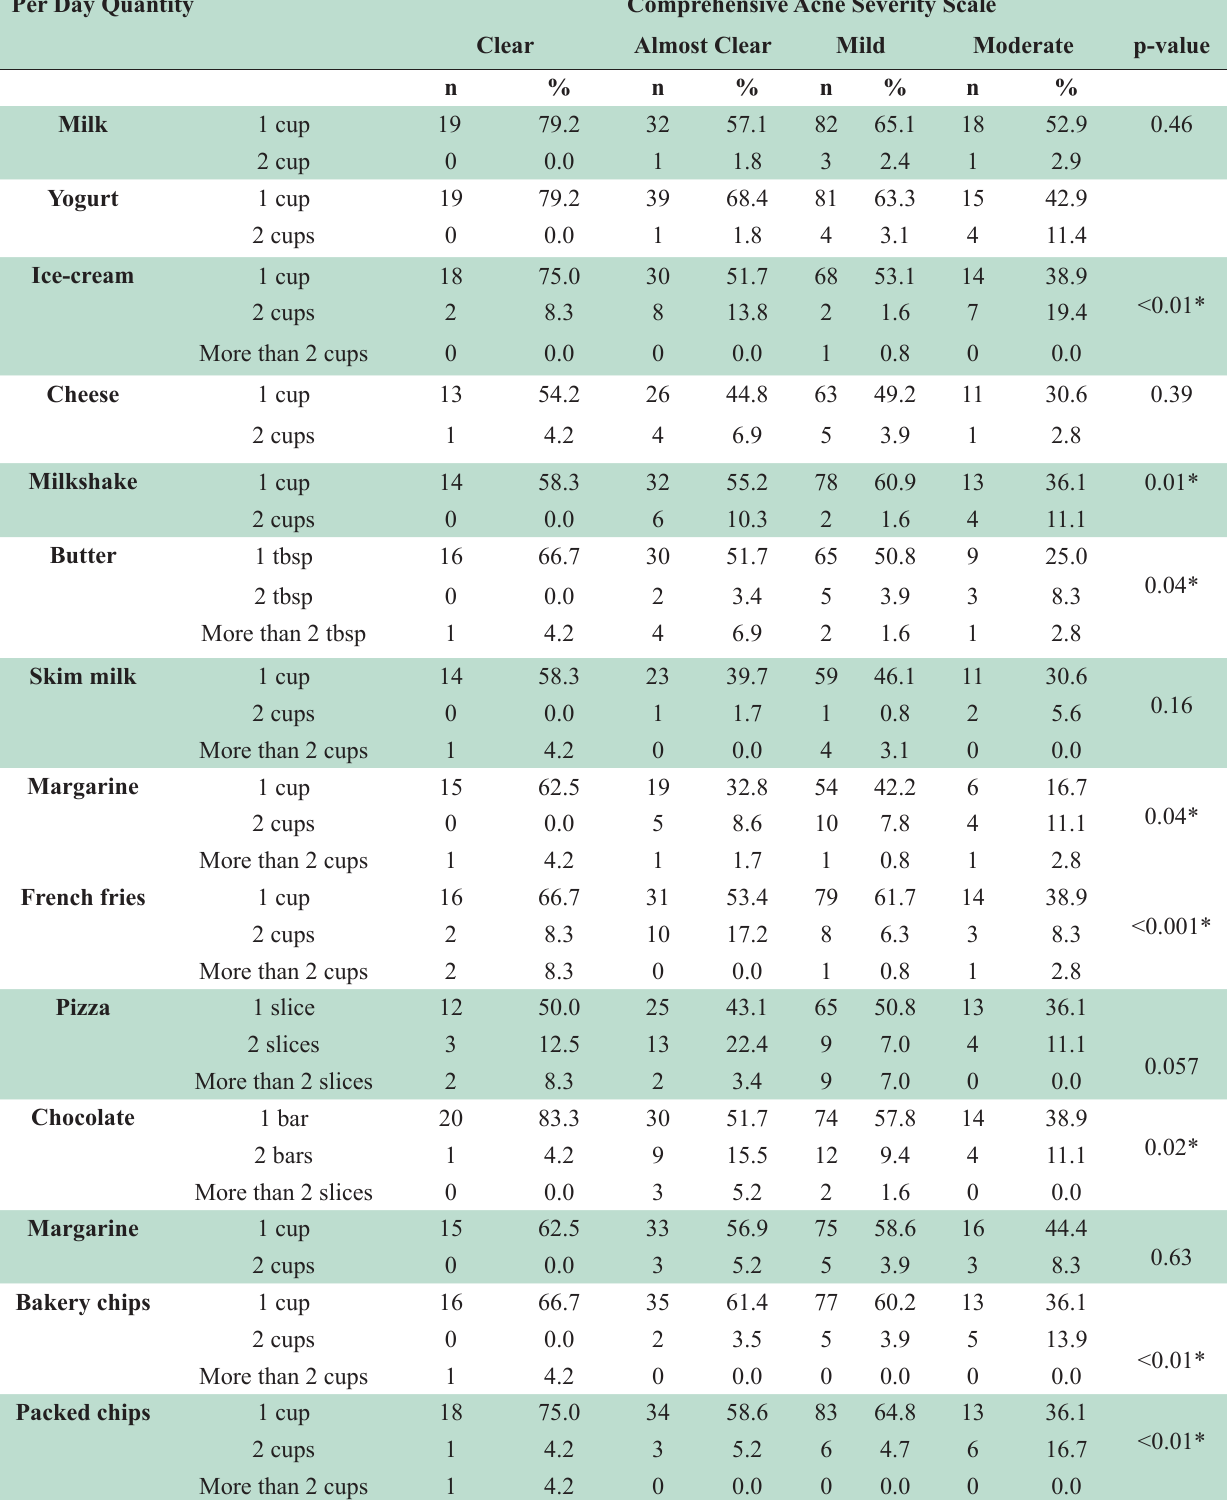
Table-III: Association of Acne with Dietary Habits. Per Day